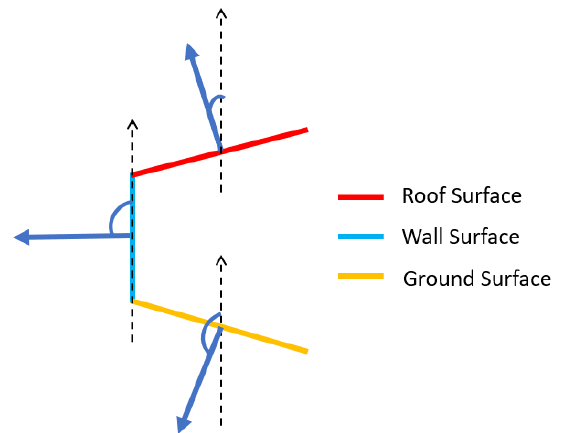
Figure 15. f φ : the angle between the face normal f n ormal and the up vector of the coordinate system. Starting from a boundary surface (labeled either by semantic information transfer or by the heuristic), topological relationships are constructed by the iterative method depicted in Figure 16.